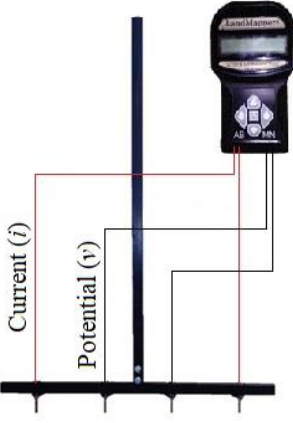
Figure 2. Wenner matrix and portable electrical conductivity meter, assembled by Landviser ® , model LandMapper ® ERM-02 (image without scale).